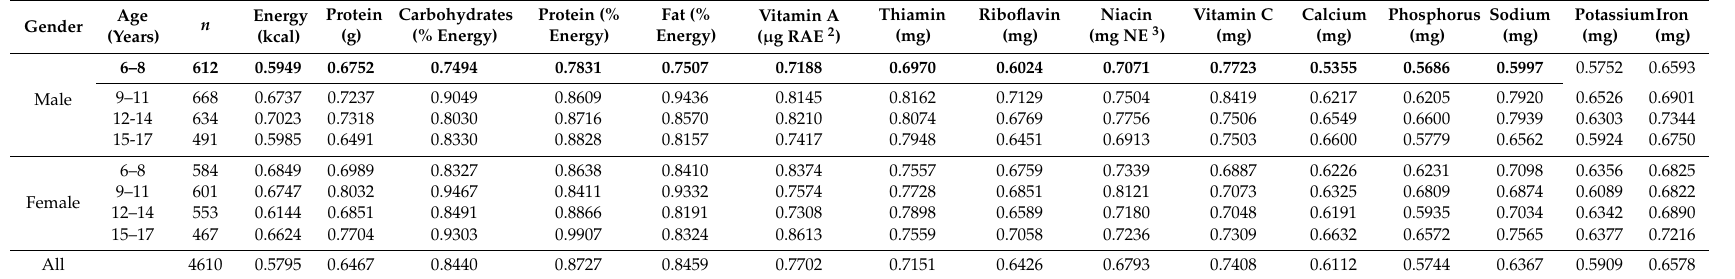
Table 1. Within-individual variance components 1 estimated through the Iowa State University (ISU) method.